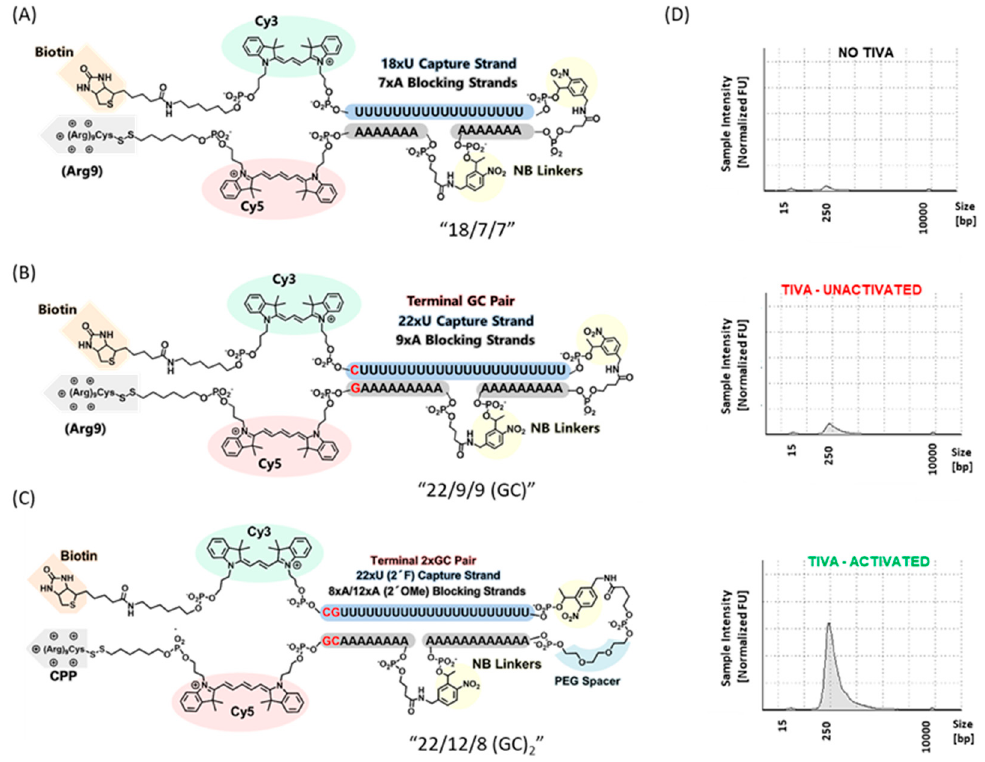
Figure 3. Three generations of TIVA probes for mRNA isolation: structure of ( A ) “18/7/7”; ( B ) “22/9/9 (GC)”; ( C ) “22/12/8 (GC) 2 ”; ( D ) Bioanalyzer traces of amplified RNA (aRNA) made from controls and RNA isolated using 22/12/8 (GC) 2 TIVA from samples that had no TIVA loaded, or loaded with TIVA, without or with light activation. Adapted from ref [91]. The figure is adapted with permission from Yeldell, S. et al. ACS Chem Biol. 2020, 15, 10, 2714–2721. Copyright (2020) American Chemical Society.